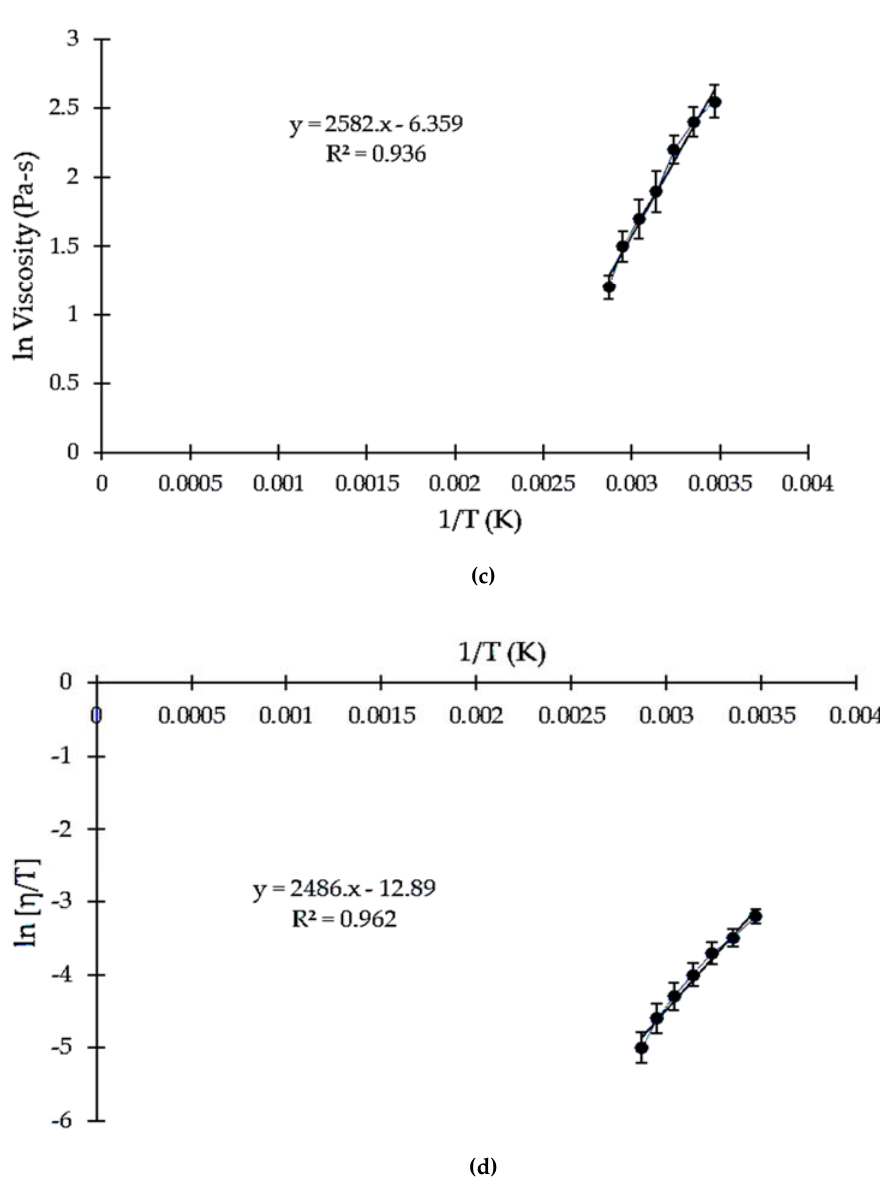
Figure 1. ( a ) The variation in viscosity with temperature (ºC), ( b ) the effect of temperature (K) on ln viscosity of the solution, ( c ) the variation in ln viscosity with temperature (K), and ( d ) the variation in ln [ η /T] with temperature (1/T).